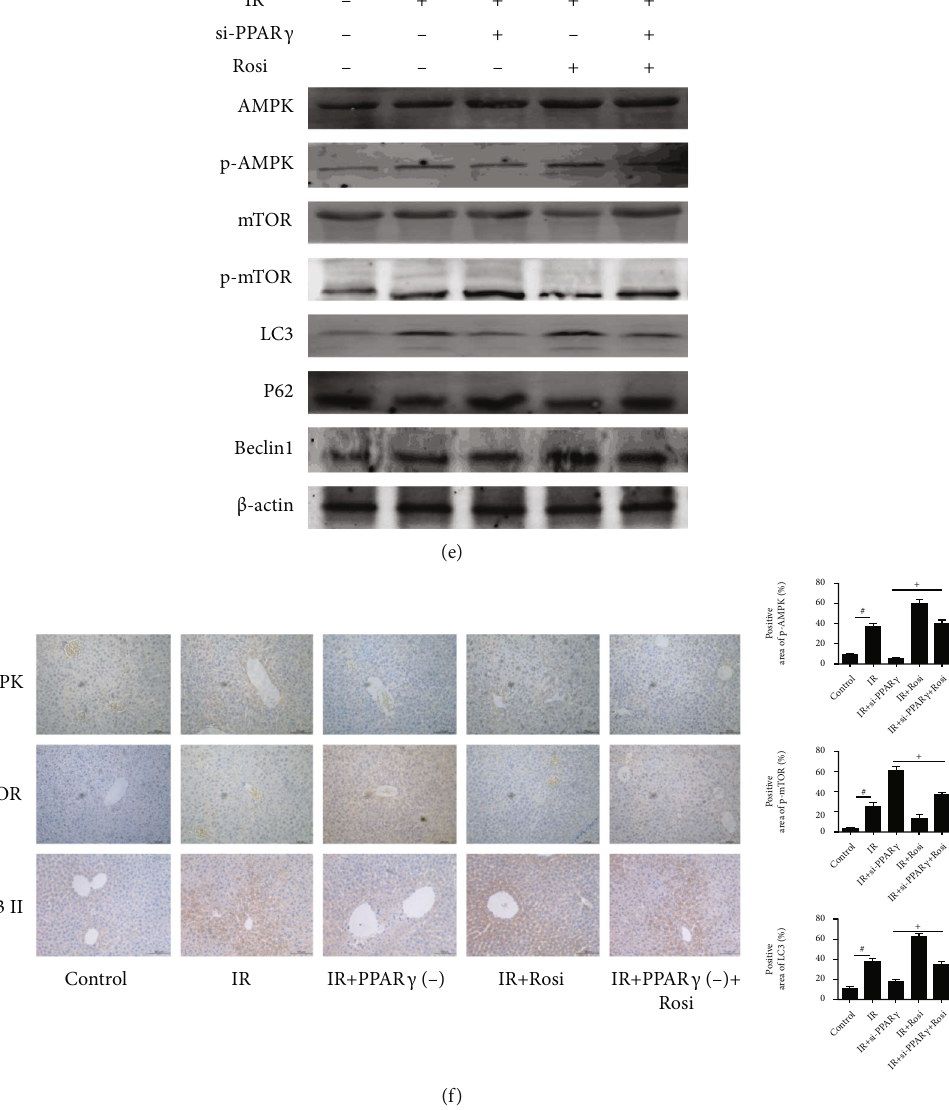
Figure 4: The in fl uence of PPAR γ in IR may be linked with the AMPK/mTOR/autophagy signaling pathway. Notes: (a) the levels of serum ALT and AST for IR after 12h ( n = 5 , # means p < 0 : 05 for si-PPAR γ versus IR, + means p < 0 : 05 for si-PPAR γ +Rosi versus si-PPAR γ ); (b) the levels of serum TNF- α and IL-1 β for IR after 12h ( n = 5 , # means p < 0 : 05 for si-PPAR γ versus IR, + means p < 0 : 05 for si-PPAR γ +Rosi versus si-PPAR γ ); (c) protein expression of TNF- α , IL-1 β , Bax, and cleaved caspase9 for IR after 12 h ( n = 3 , # means p < 0 : 05 for si-PPAR γ versus IR, + means p < 0 : 05 for si-PPAR γ +Rosi versus si-PPAR γ ); (d) TUNEL staining ( × 200) showed apoptotic cells in mice liver for IR after 12h; (e) protein expression of AMPK, p-AMPK, mTOR, p-mTOR, LC3, and Beclin1 for IR after 12h ( n = 3 , # means p < 0 : 05 for IR versus control, + means p < 0 : 05 for IR ± si-PPAR γ ± Rosi versus IR); (f) immunohistochemistry staining ( × 200) showing the expression of p-AMPK, p-mTOR, and LC3 for IR after 12 h ( n = 3 , # means p < 0 : 05 for IR versus control, + means p < 0 : 05 for IR ± si-PPAR γ ± Rosi versus